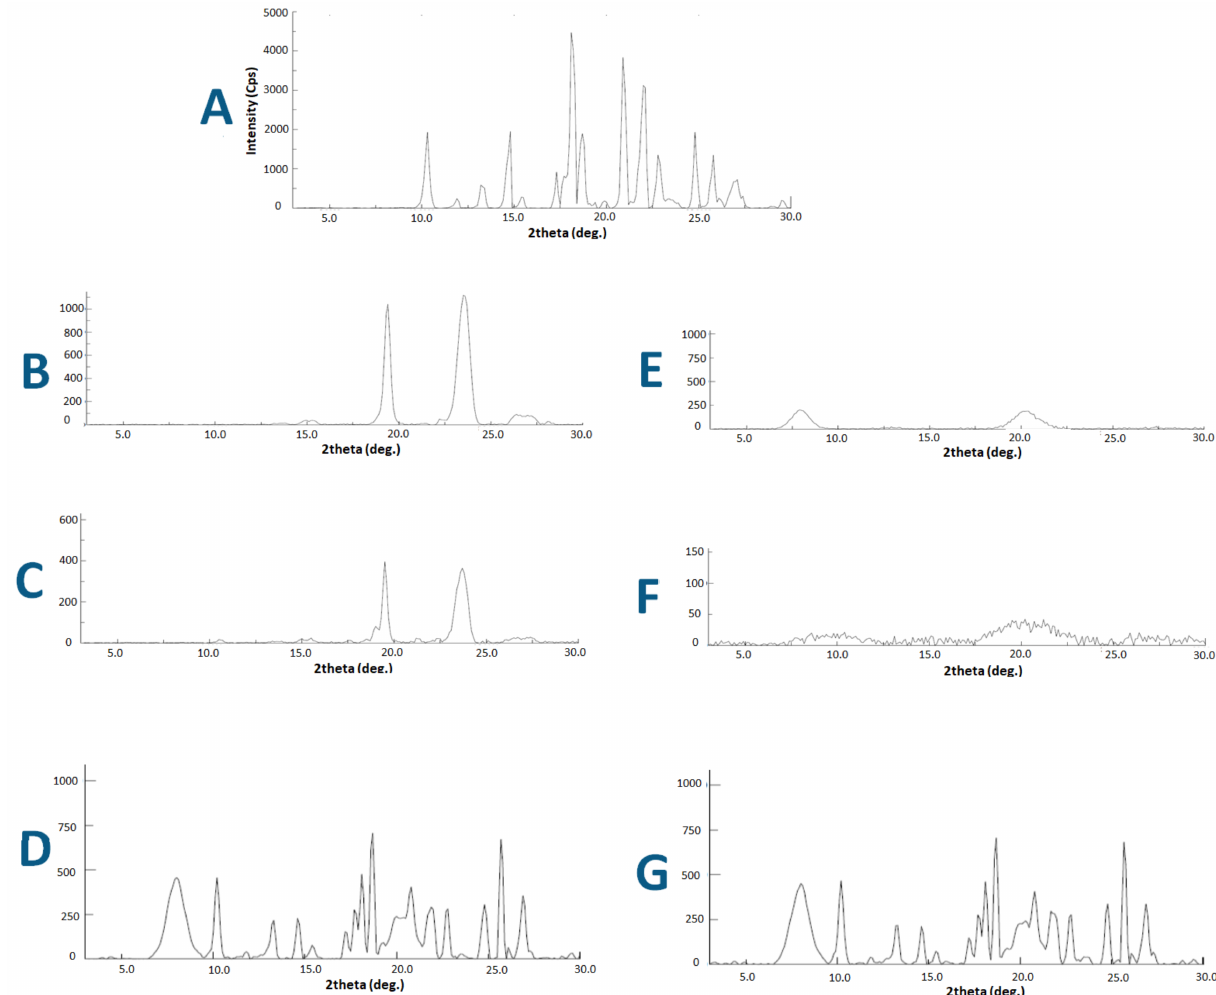
Figure 3. XRD analysis of ( A ) pure CN, ( B ) Pure PL-127, ( C ) MW-SD, ( D ) CN/ PL-127 physical mixture, ( E ) pure HPMC, ( F ) FD-SD formulations and ( G ) CN/HPMC physical mixture. FD-SD: freeze drying induced solid dispersion, MW-SD: microwave induced solid